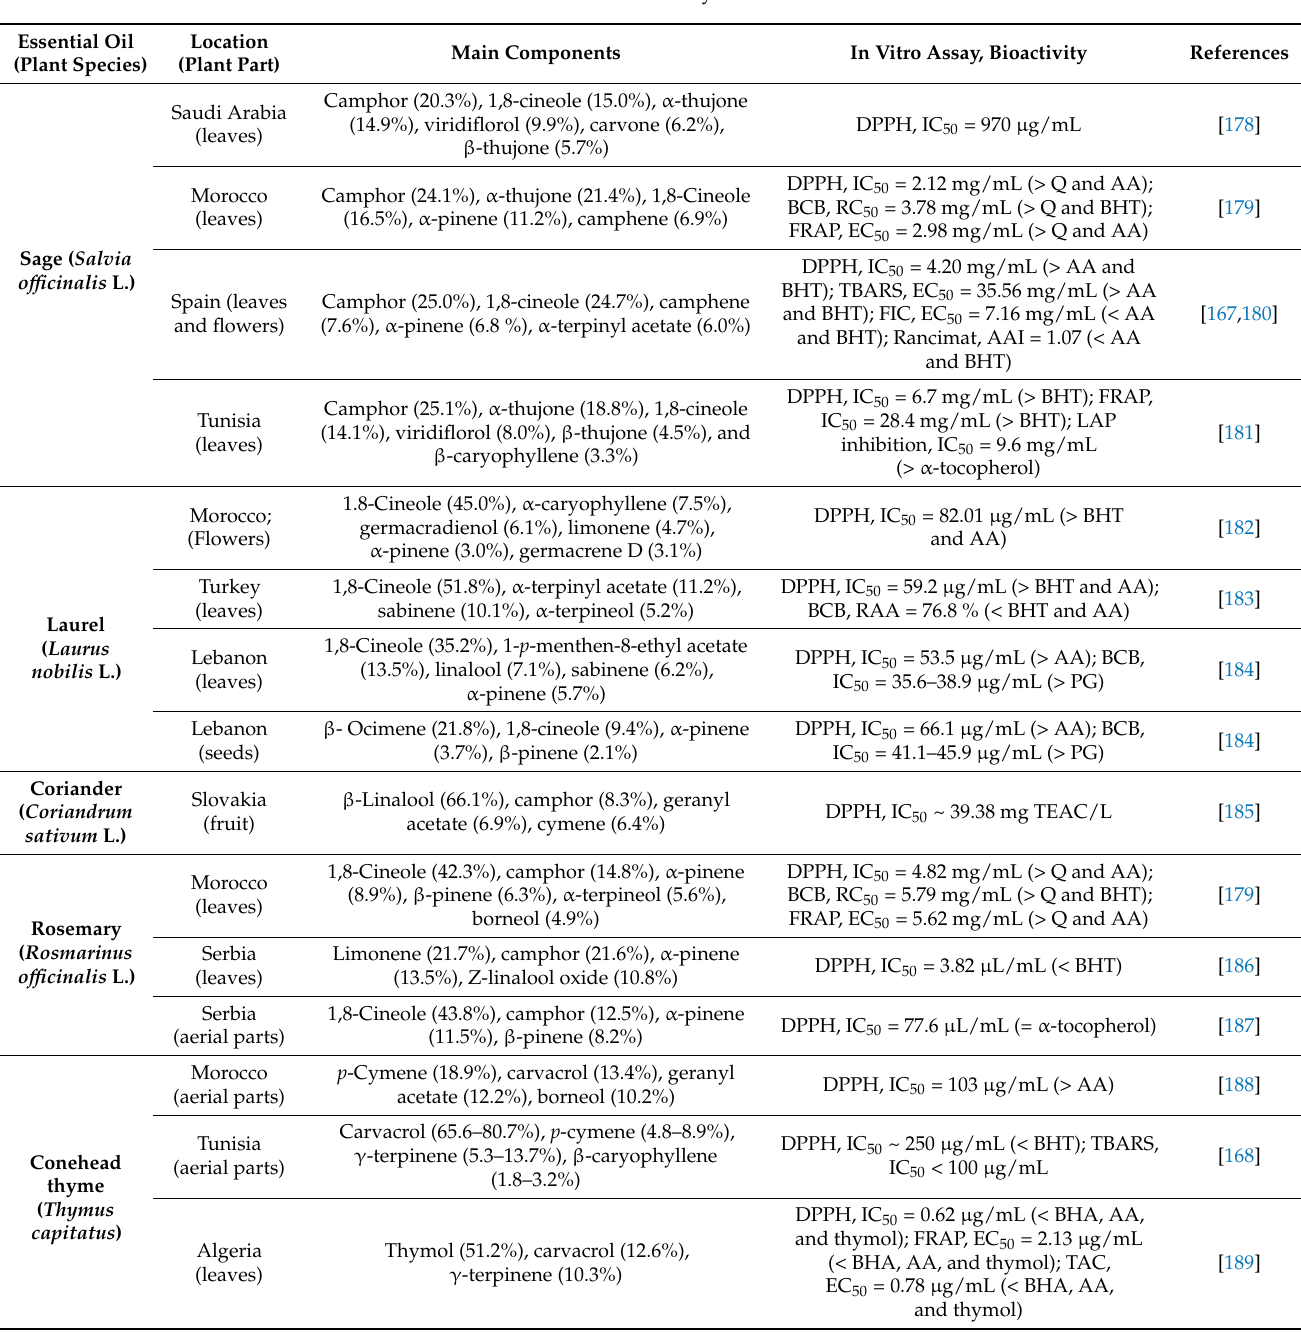
Table 3. Antioxidant activity of selected